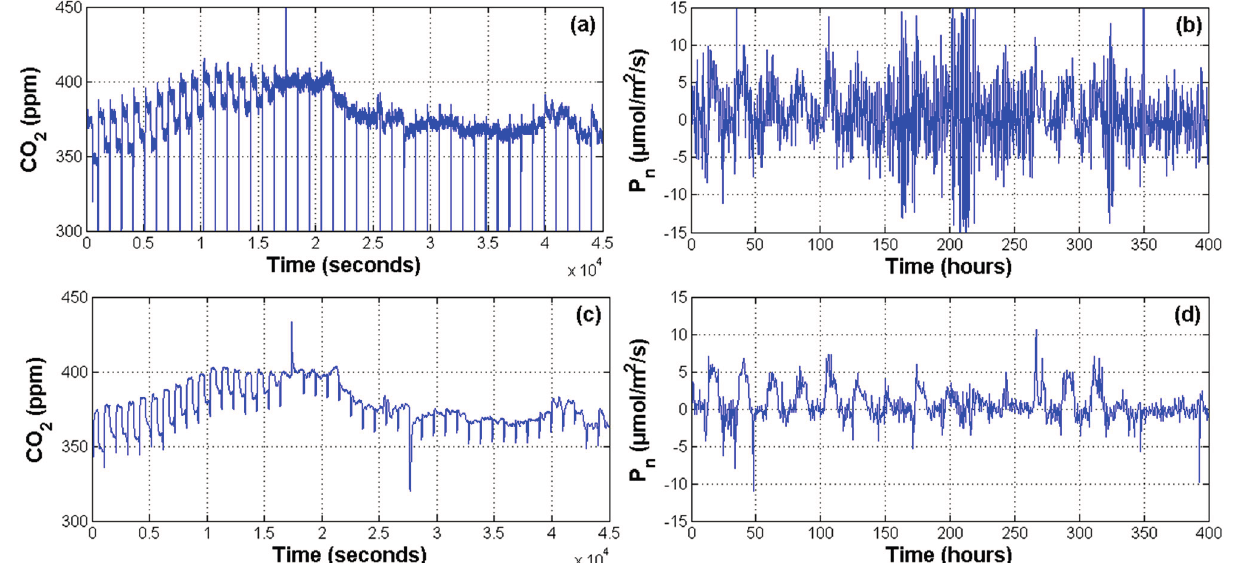
Figure 6. Digital filtering results over photosynthesis estimation. ( a ) Non-filtered CO 2 signal; ( b ) P n estimation based on raw signals; ( c ) filtered CO 2 signal; and ( d ) P n estimation based on filtered